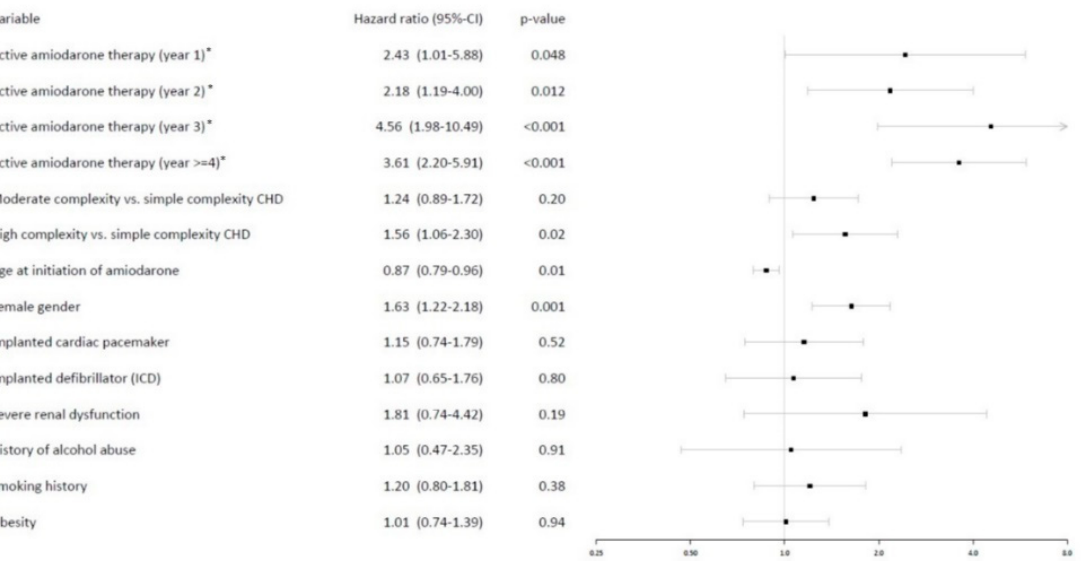
Figure 2. Risk factors for thyroid dysfunction based on the results of the multivariate time- dependent Cox regression analysis in all patients receiving amiodarone. * active amiodarone intake defined as prescription of amiodarone within 90 days before and after analyzation time. To avoid the problem of non-proportional hazards, a stepwise analysis showing yearly intervals was used, thus allowing the corresponding coefficient to be time-varying.